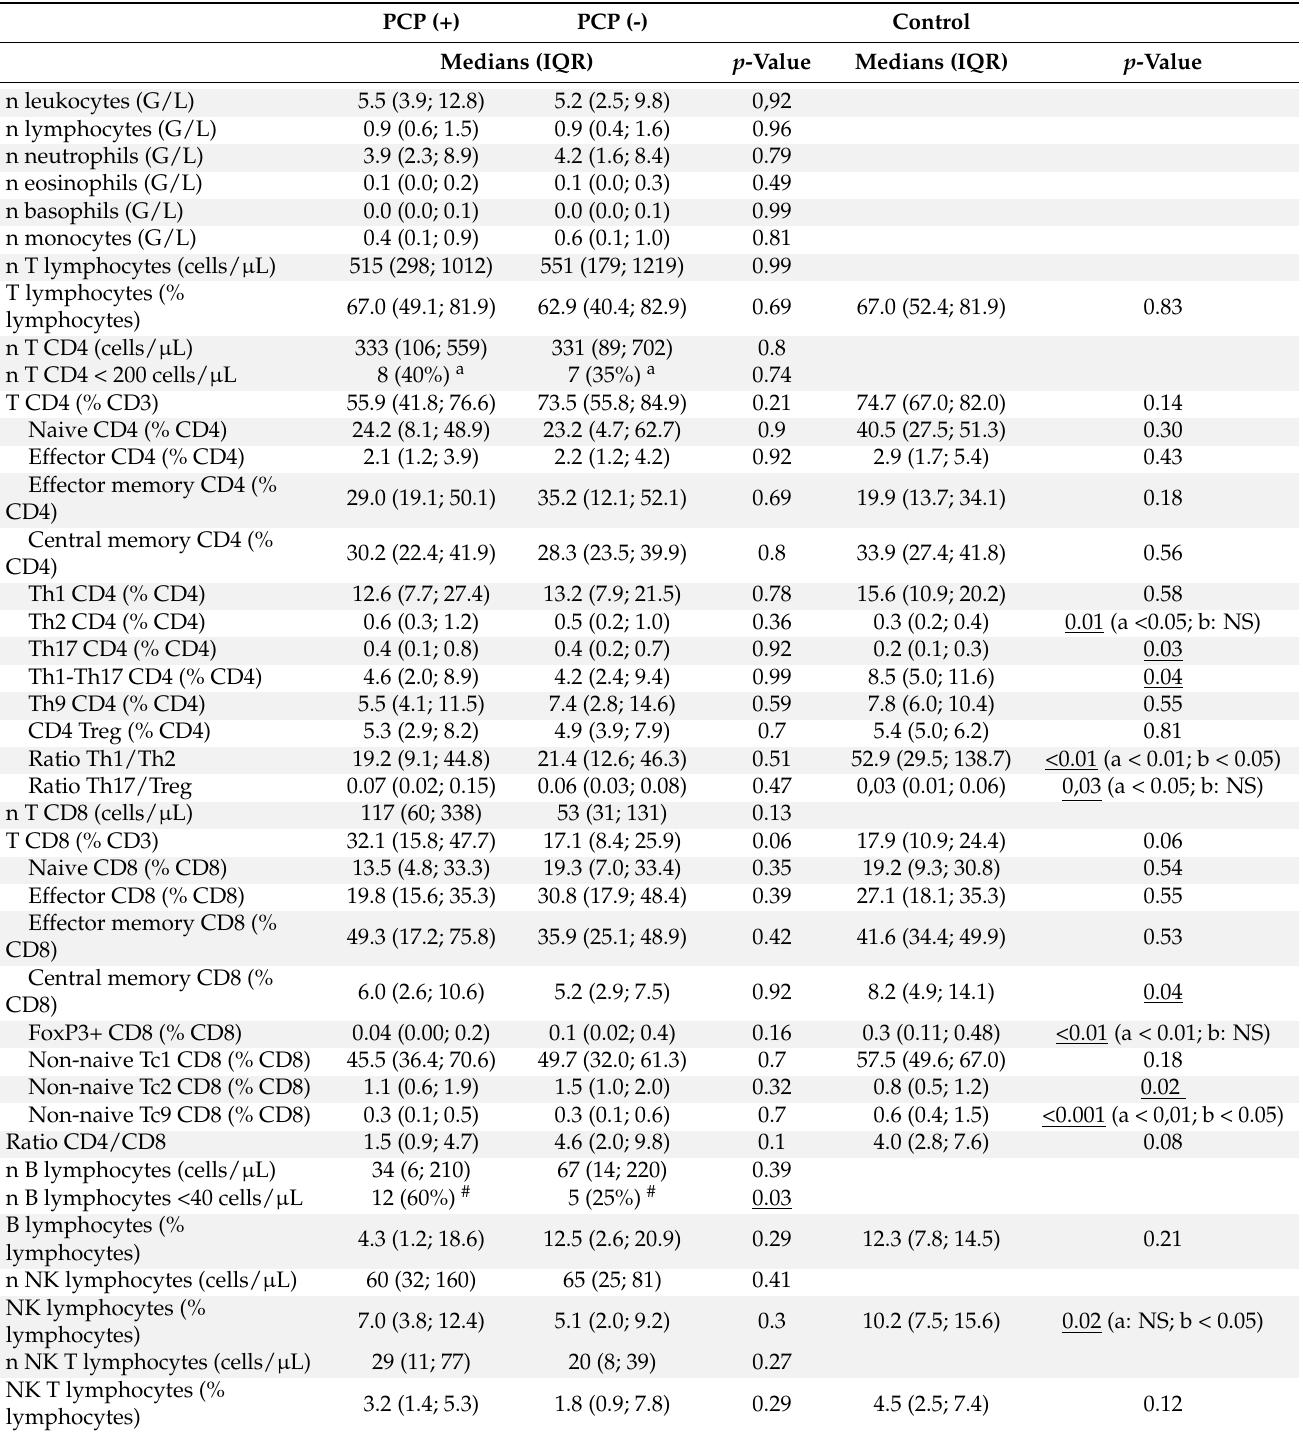
Table 2. Peripheral blood lymphocyte populations and subpopulations in PCP positive, PCP negative and control